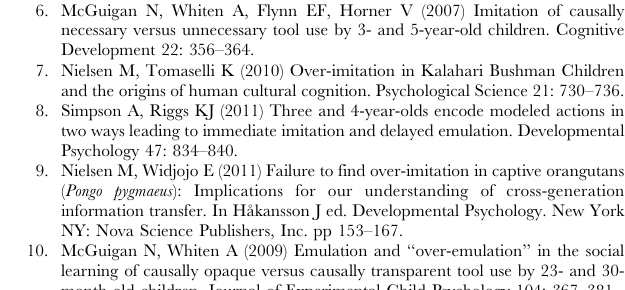
Table S3 Proportion of participants who performed: